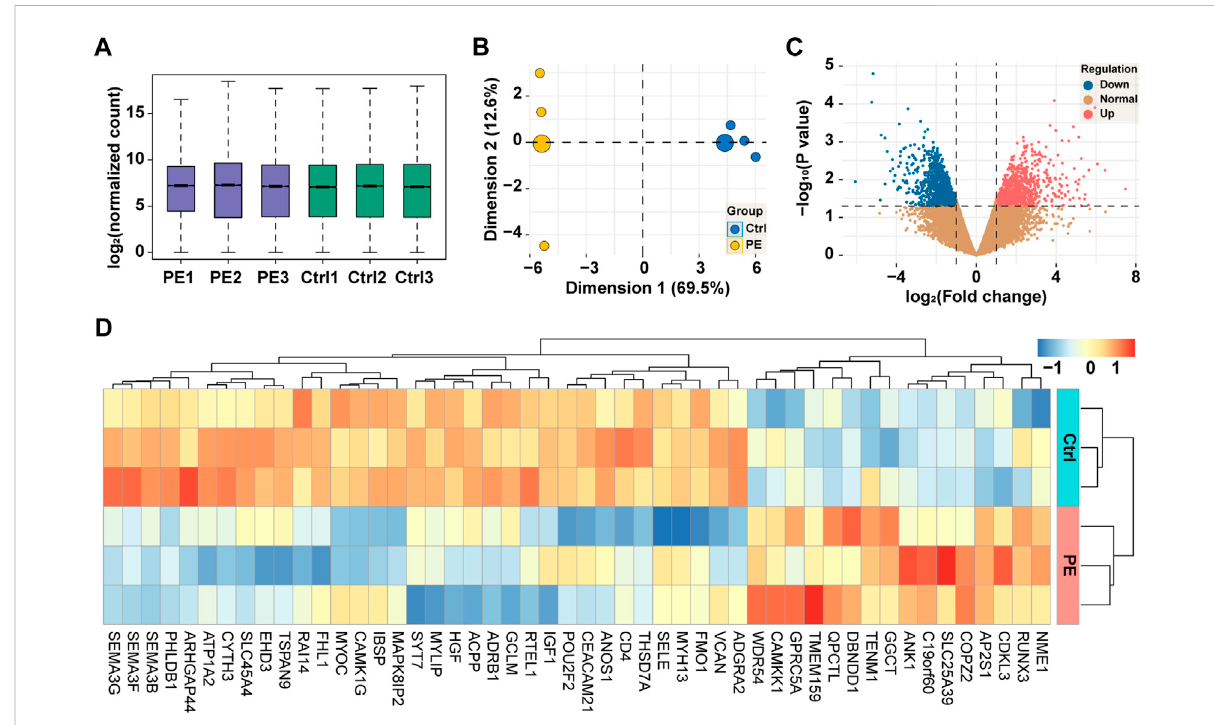
FIGURE 2 High-throughput sequencing of placental tissues. (A) Box-and-whisker plot showing the expression of genes in each sample. (B) Principal component analysis of samples based on the expression of genes at the genome-wide level. (C) Volcano plot showing the expression of genes between groups. Red, upregulation; blue, downregulation; yellow, normal. (D) Heatmap showing the expression of top 50 dysregulated genes with clustering analysis. PE, pre-eclampsia; Ctrl,